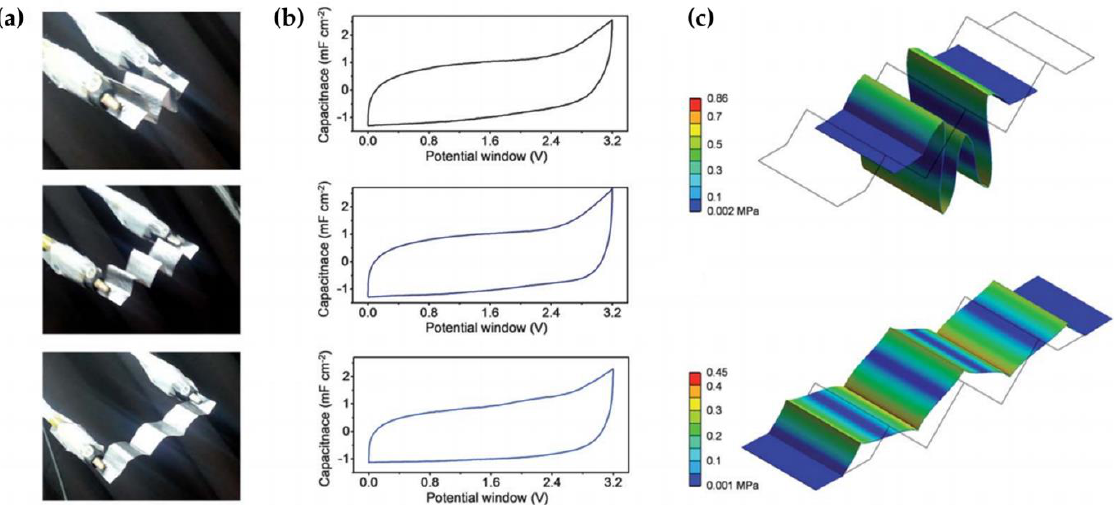
Figure 4. ( a ) Photographs of an origami-based stretchable energy system with three isolated electrodes (IEs) at about 60% (compressible), tensile of 0% and 30%. ( b ) CVs of a compressible state at about 60%, tensile of 0% and 30% ( c ) 3D finite element (3D FEM) modeling of stress distribution for the equivalent system under the same compressibility and tensile strain [49]. Copyright (2014), The Royal Society of Chemistry.